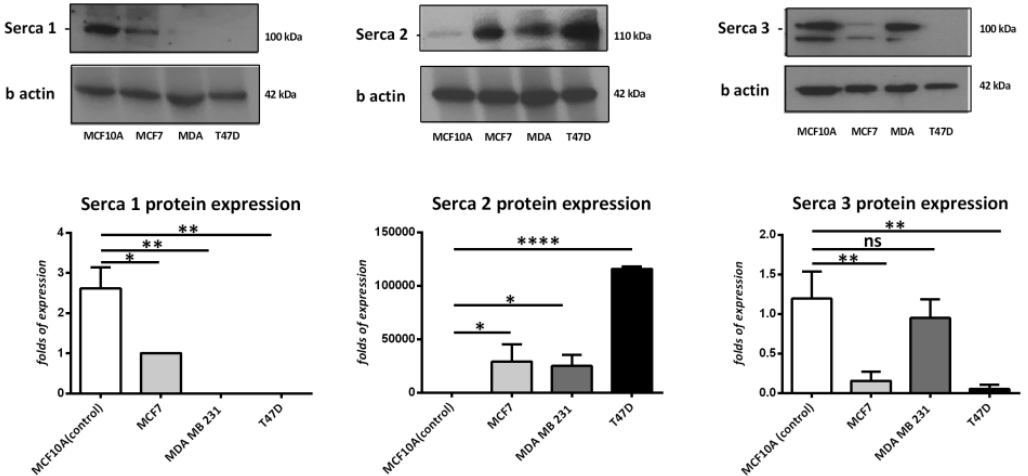
Figure 1. Western blot analysis of SERCA isoforms in breast cancer cell lines (MDA-231, MCF-7, MCF10A, and T47D). The analysis was performed in three independent experiments ( n = 3), except in the case of Serca1, where n = 2. * p < 0.05, ** p < 0.01, **** p < 0.0001.